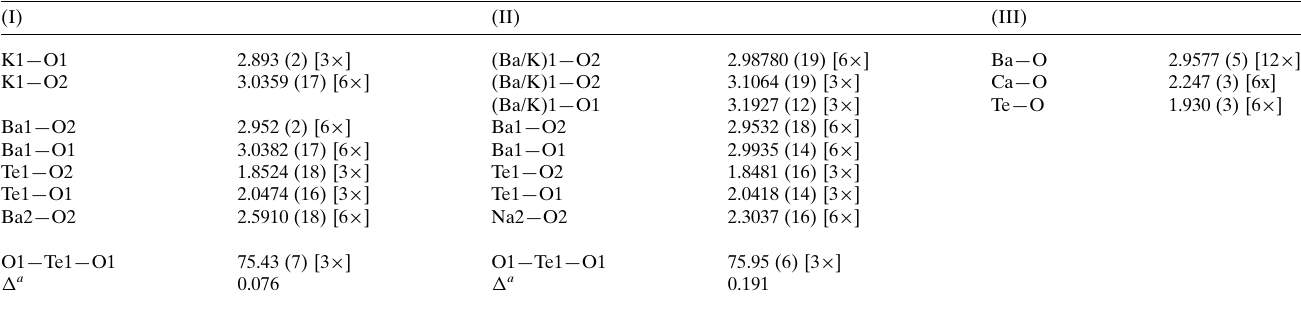
Table 1 Selected bond lengths (A˚ ) and angles ( (cid:3) ) in the structures (I)–(III). (I)